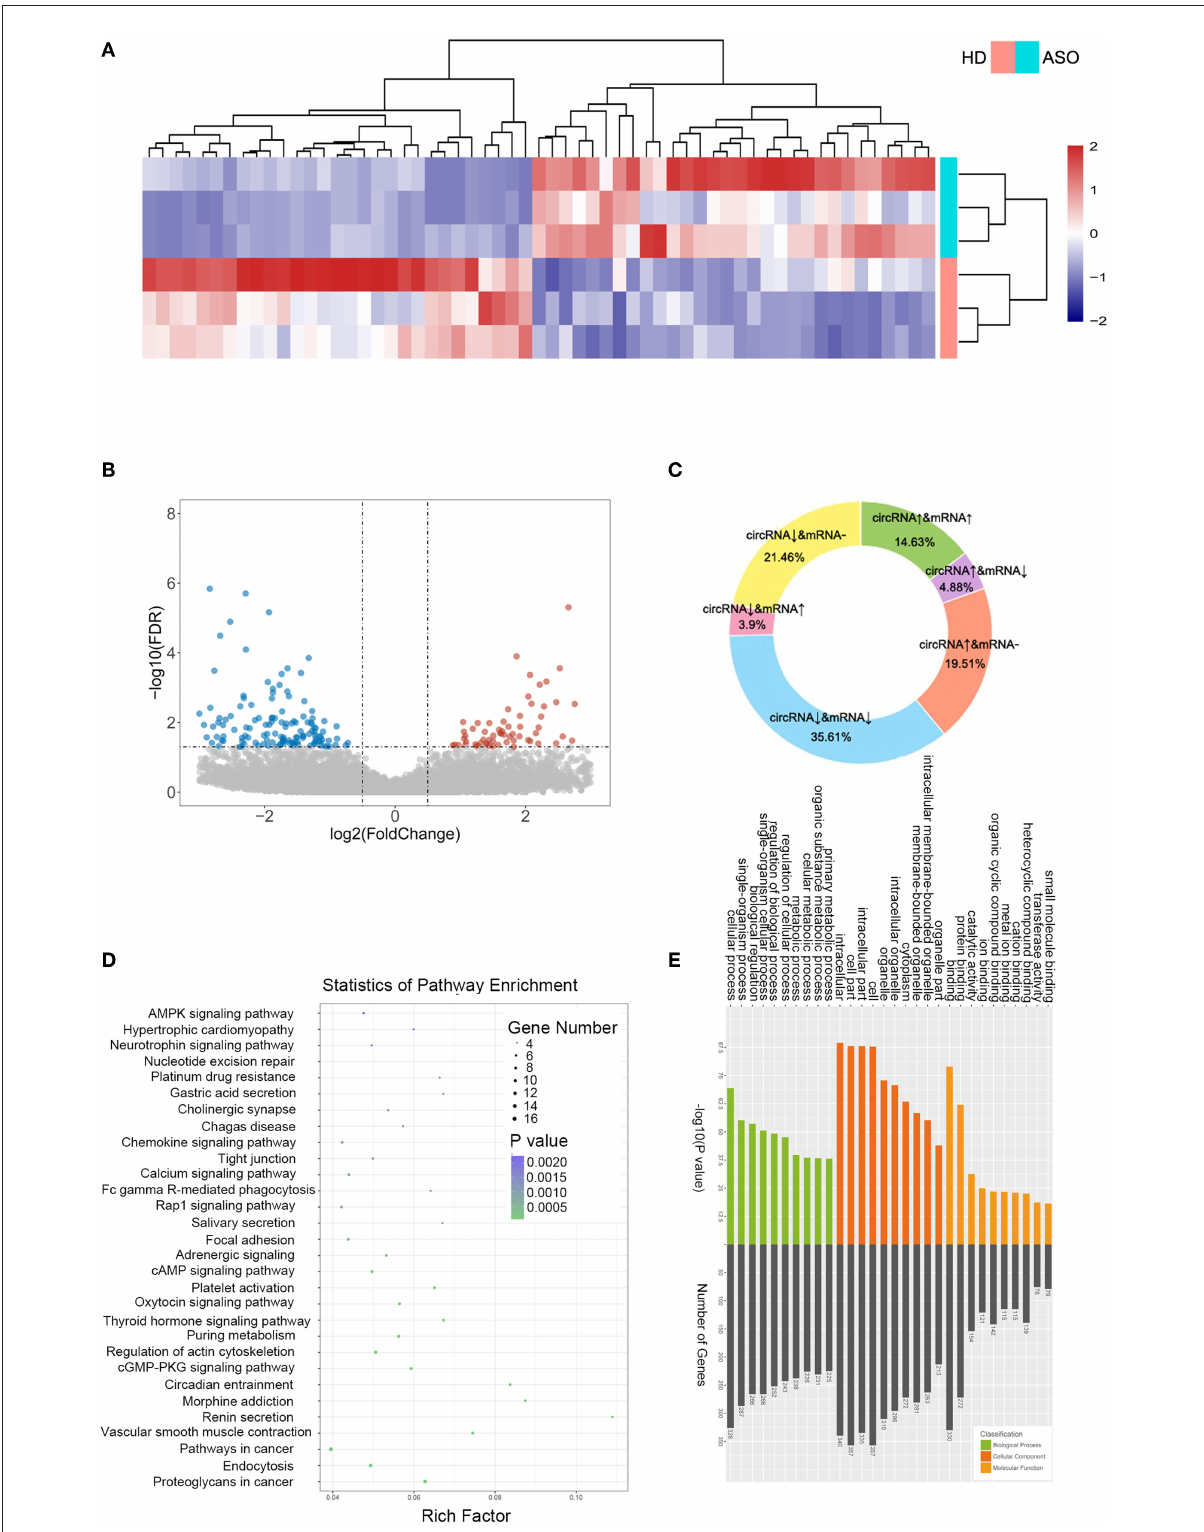
FIGURE2 CircRNA expression profiles between patients with ASO and healthy donors. (A) A heatmap of the top 60 differentially expressed RNAs (DEcircRNAs) between patients with ASO and healthy donors; (B) A volcano plot of all the circRNAs. Blue dots indicate the downregulated circRNAs in patients with ASO, and red dots indicate the upregulated circRNAs; (C) A pie chart of the sequencing results; (D) A bubble diagram showing the Kyoto Encyclopedia of Genes and Genomes (KEGG) pathway analysis results of DEcircRNAs; and (E) GO analysis of